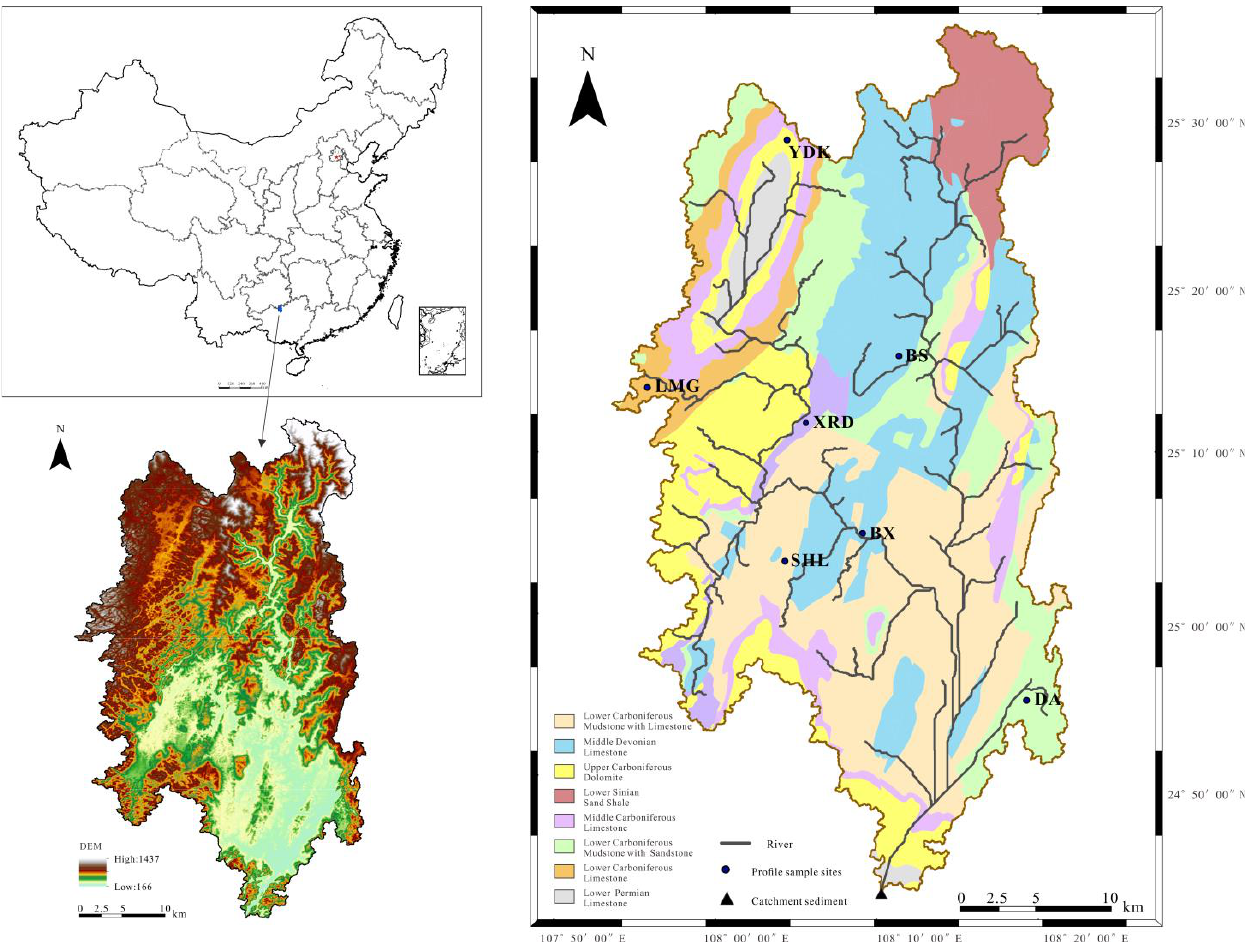
Figure 1. Study catchment area and the location of sampling